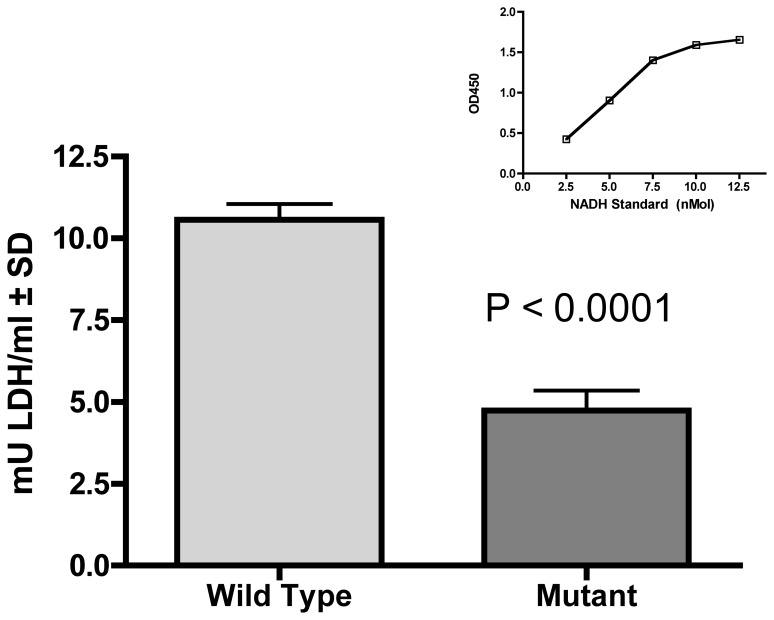
Lactate dehydrogenase production in the Mycoplasma mycoides subsp. capri GM12 wild type and the ctpA(clpP)::tetM mutant.Production of lactate dehydrogenase (LDH) by 106 cells/ml of either the wild type or mutant was determined after a 30 min incubation with 100 µM glycerol. LDH production was significantly increased (P<0.0001, unpaired T test) in the mutant. The standard reference curve is shown in the inset.